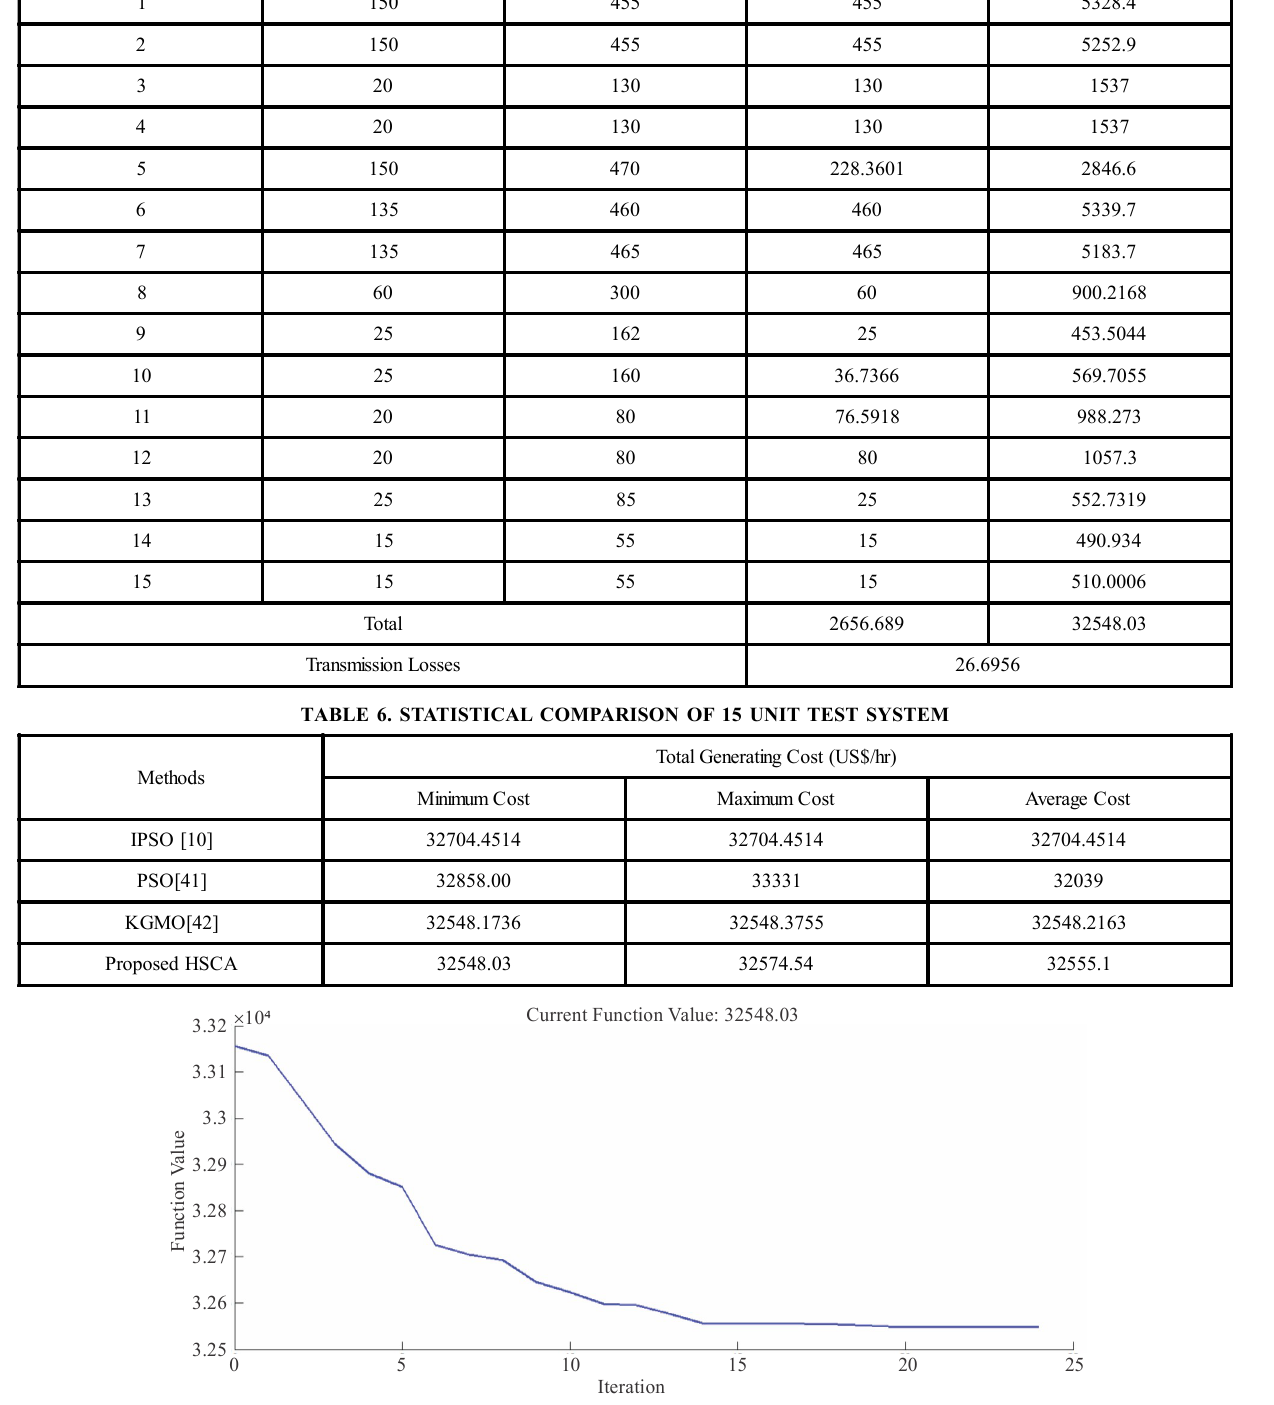
FIG. 6. CONVERGENCE CURVE FOR TEST